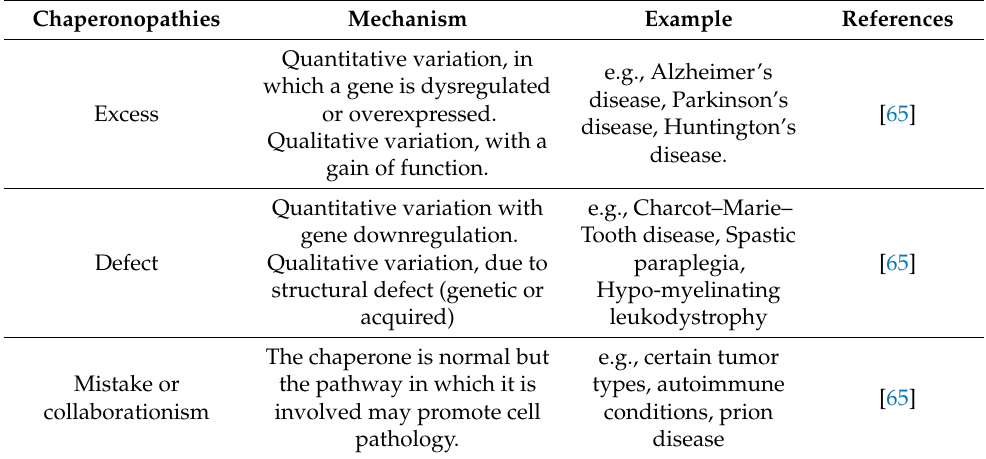
Table 1. Classification of chaperonopathies according to pathogenic mechanism. Chaperonopathies